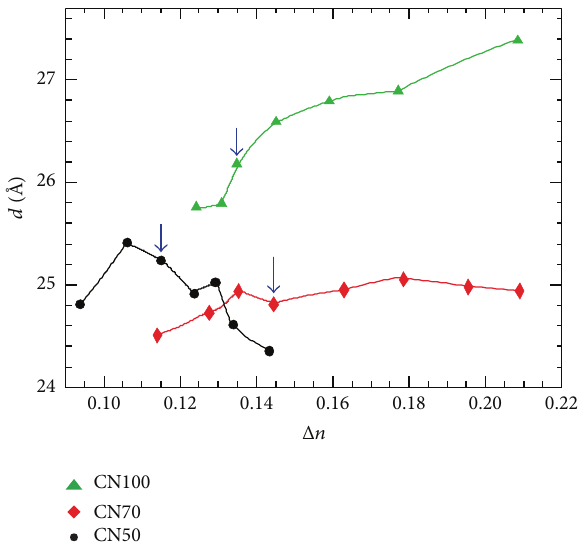
Figure 11: Plot of 𝑑 versus Δ𝑛 . Arrows point to Δ𝑛 values at 𝑇 ∗ = 60 ∘ C.